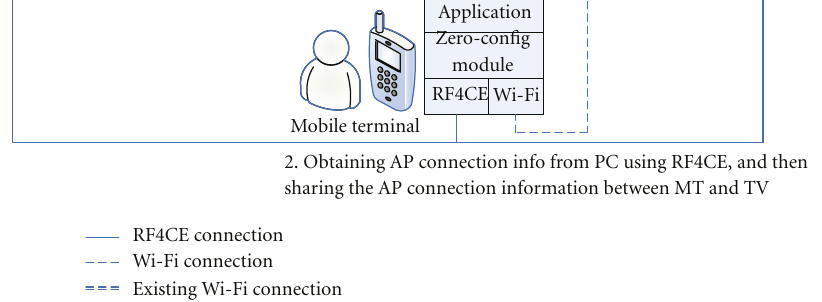
Figure 4: Infrastructure connection mode in zero-configuration approach.